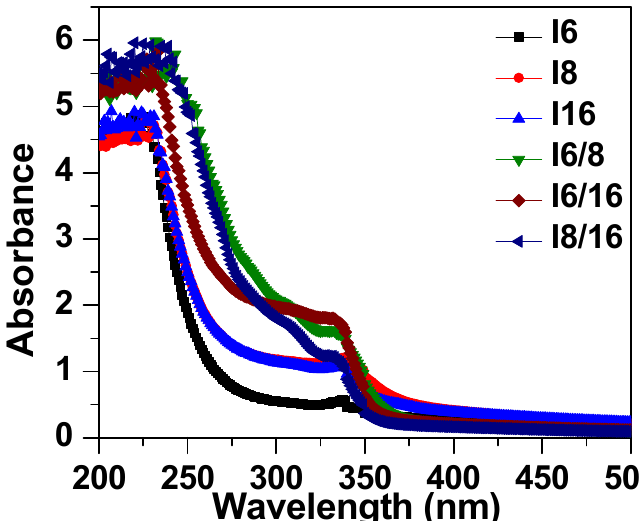
Figure 6. Absorption spectra of investigated materials In and their binary mixtures .